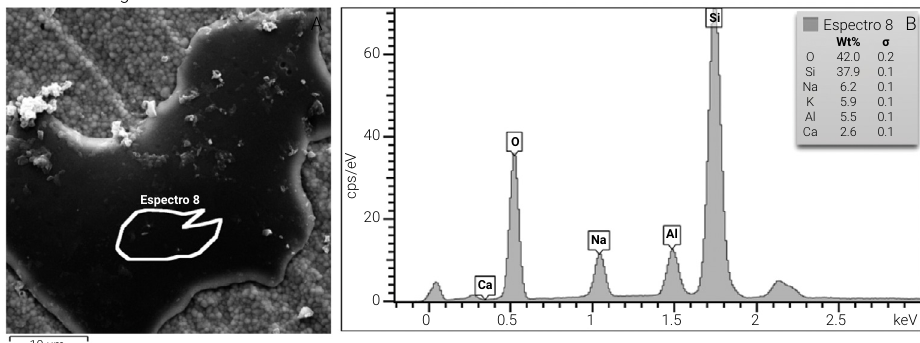
Figure 3. SEM (20,000x) of the GS60s group indicating the area analyzed by EDS (A) and the graphical representation of the EDS analysis indicating a considerable presence of silica (37.9%) in one of the “glaze islands”